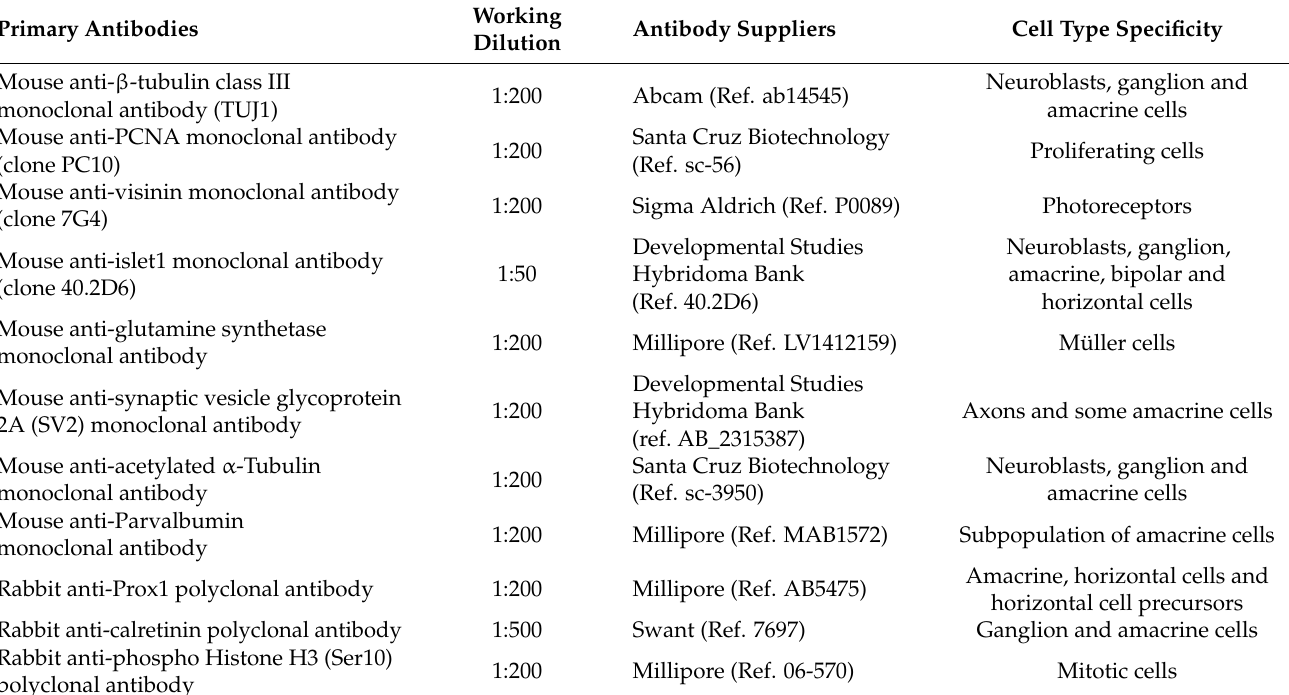
Table 2. Dilutions and sources of the primary and secondary antibodies used in the present